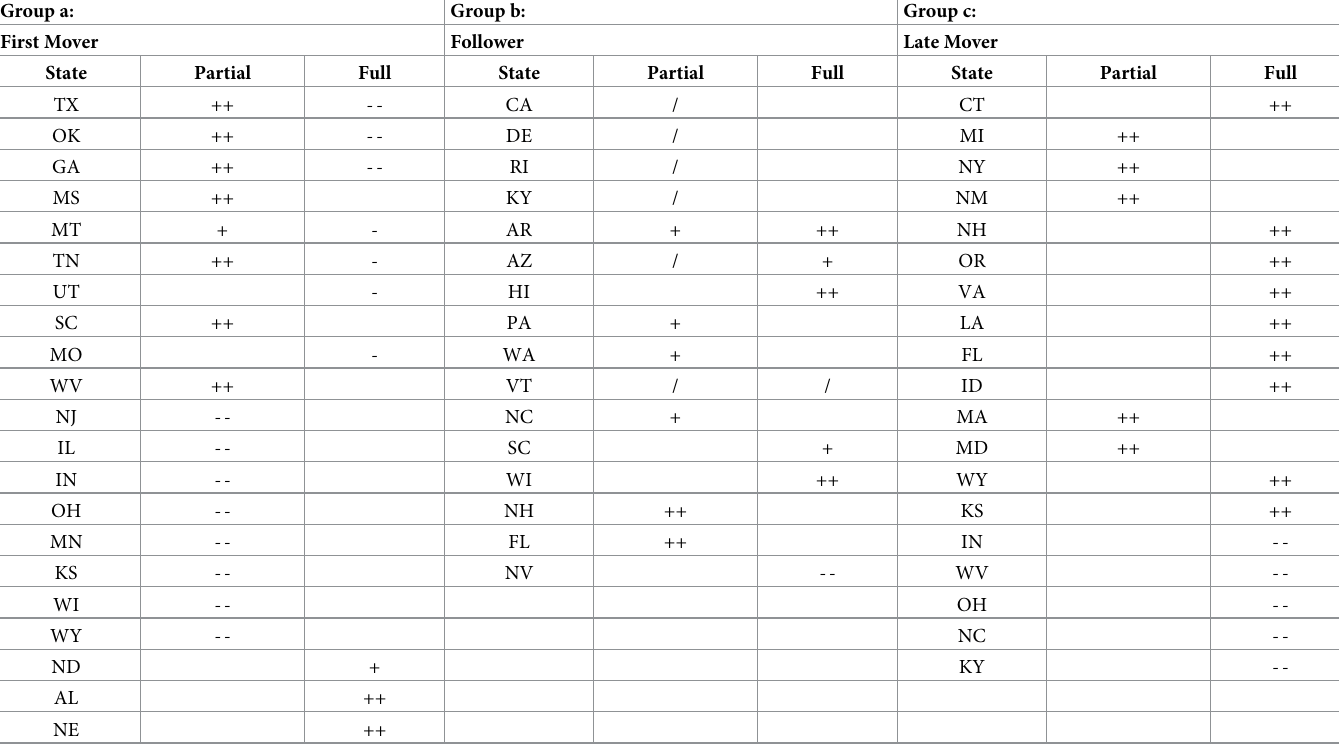
Table 2. Public reaction to reopening